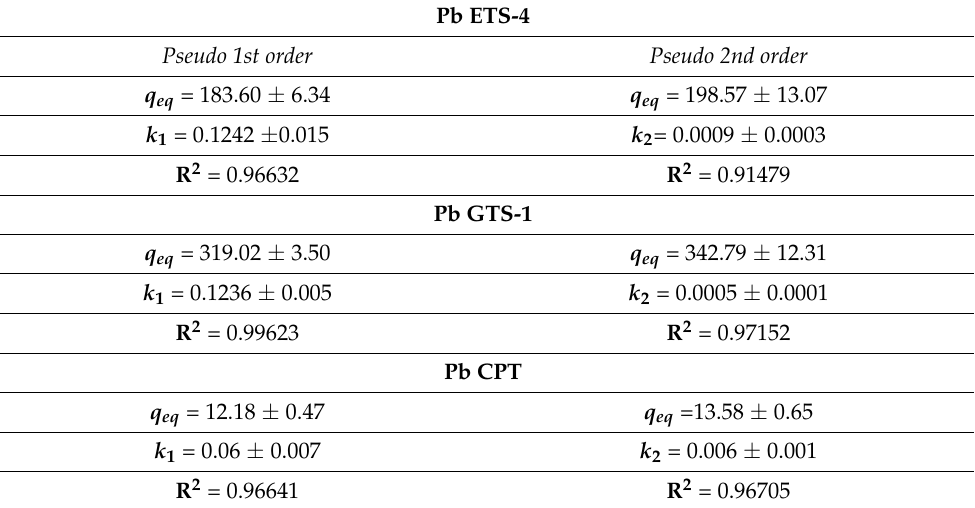
Table 3. PFO and PSO parameters.